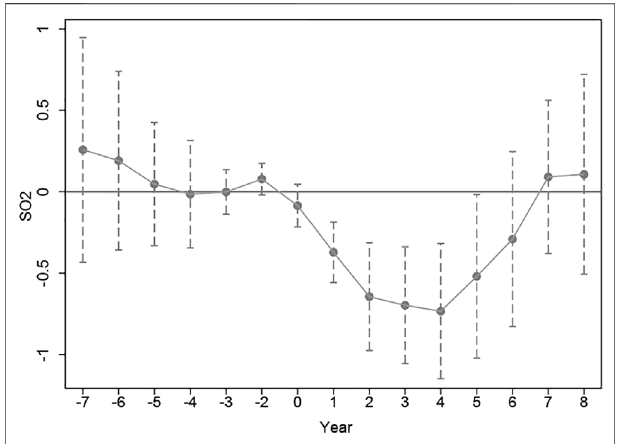
FIGURE 1 | Temporal